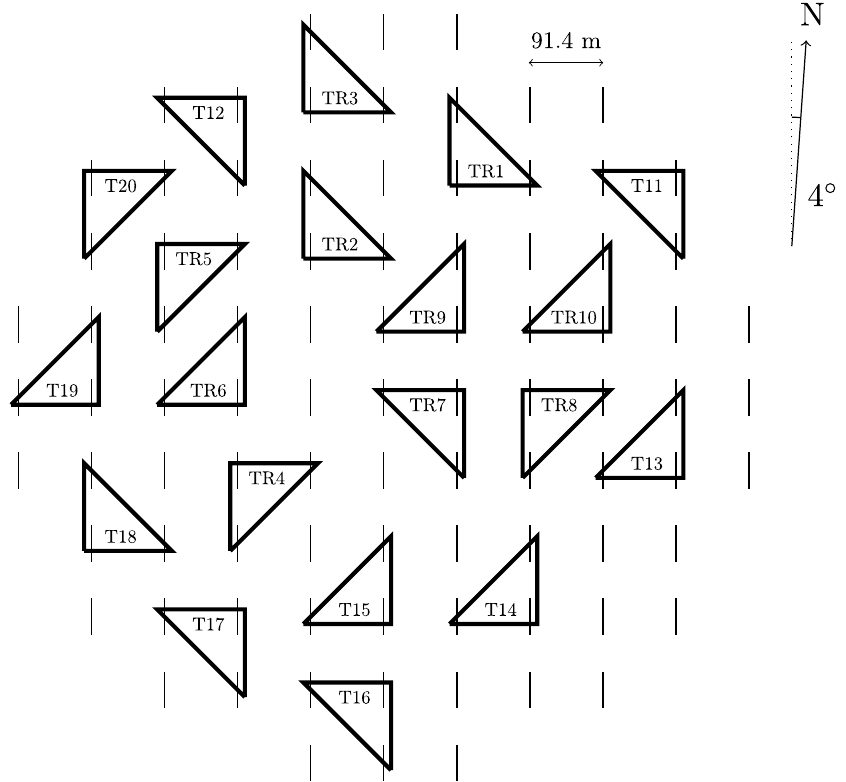
Figure 1. Antenna configuration used in the June 1998 HDI experiments. Each thin vertical line denotes an approximately north–south- oriented antenna. For ease of viewing, antenna elements have not been drawn to scale. Each bold triangle indicates a group of antennas that were connected to a given transmit or receive channel: “TR” denotes both transmit and receive, and “T” transmit only. Table 1. Error codes for the HDI